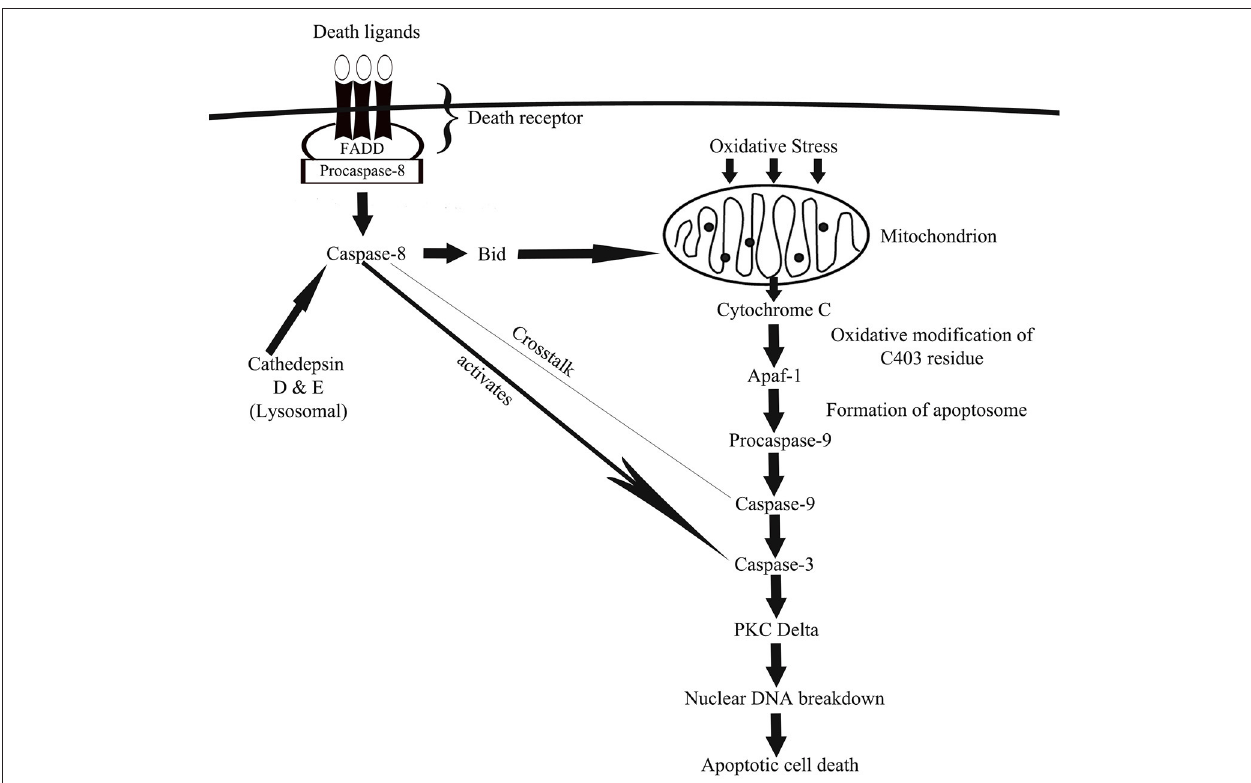
FIGURE 1 | A schematic depiction of how caspase-associated pathways leads to oxidative damage via mitochondrial- and death receptor-mediated cellular apoptosis. In mitochondrial-mediated apoptosis, generation of ROS causes the release of cytochrome C from mitochondria, which via a cascade of cellular actions activates caspase-9 and then caspase-3 that eventually channels cell death. In death receptor-mediated apoptosis, oxidative stress-driven death ligands activates caspase-8, which then activates a pro-apoptotic protein known as Bid, which once activated travels to mitochondria to facilitate mitochondria-mediated apoptotic pathway. Death receptor-activated caspase-8 also activates caspase-3 to induce cell